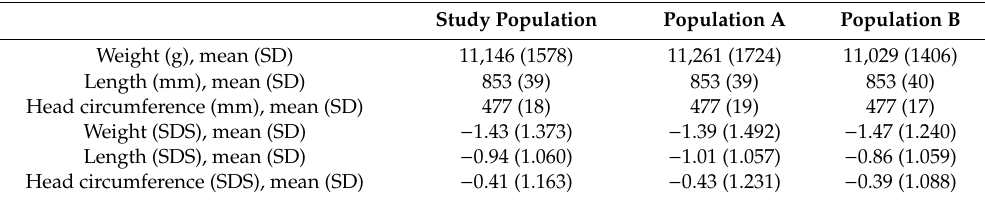
Table 4. Raw means of auxological variables at 24–30 months of